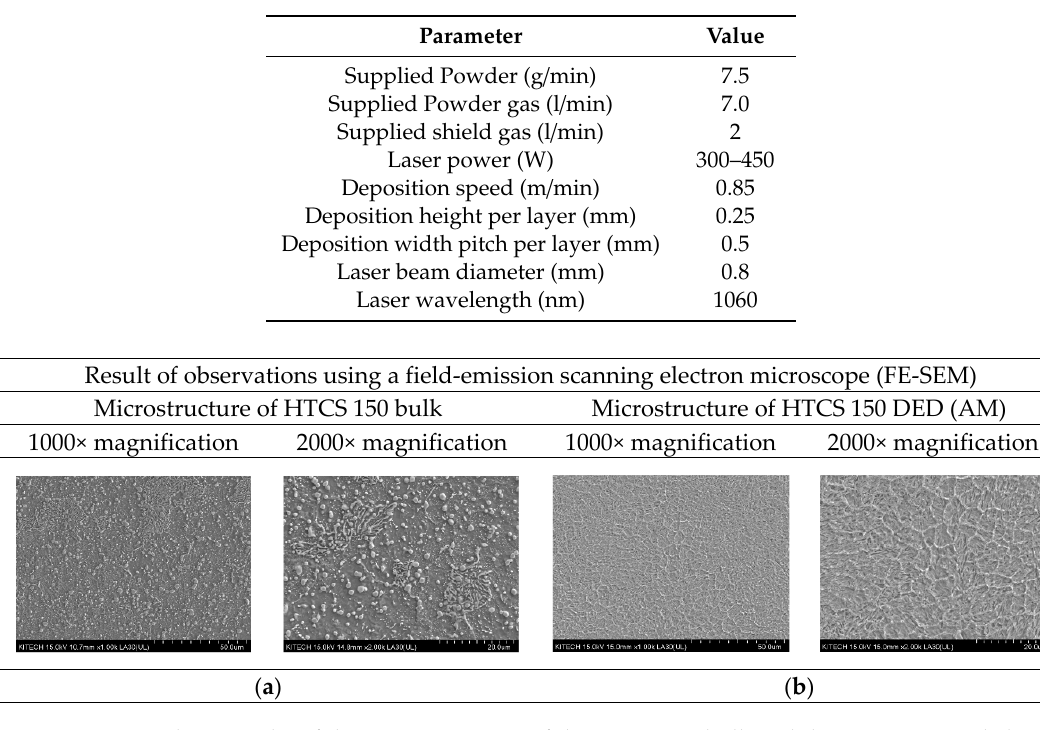
Table 4. DED process conditions for trial products of HTCS-150.